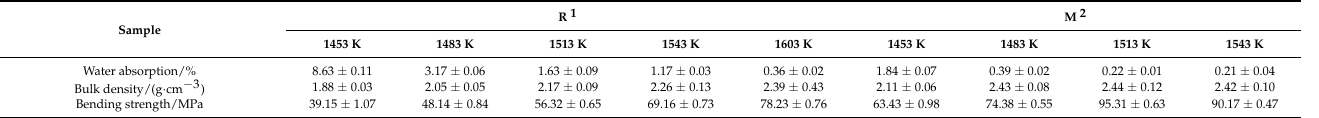
Table 4. Water absorption (%), buck density (g/cm 3 ), and bending strength (MPa) of R and M at different temperatures.